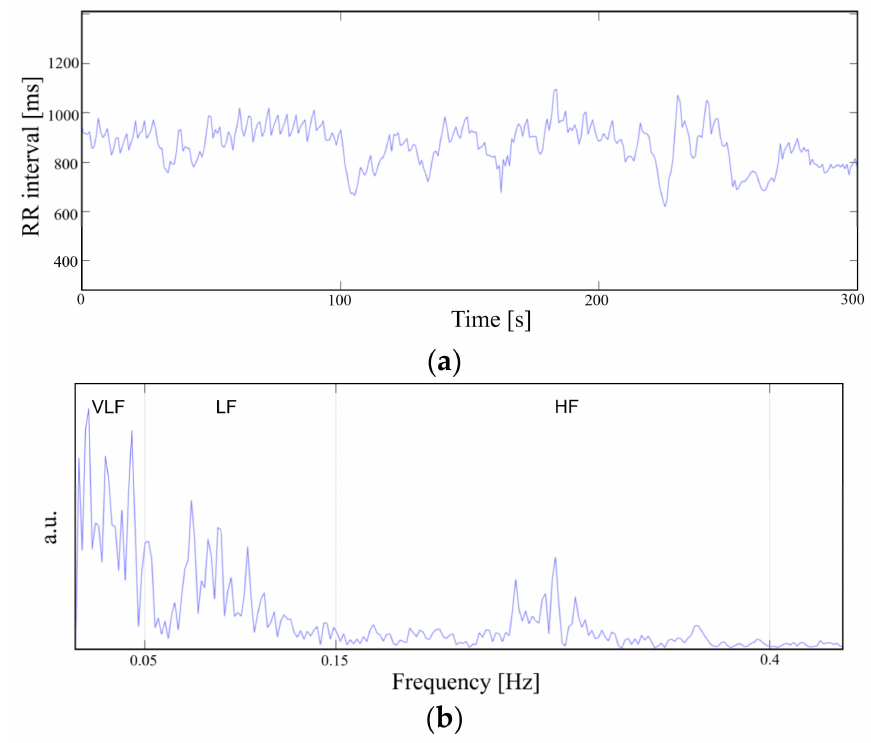
Figure 15. Heart rate variability in ( a ) time domain and ( b ) frequency